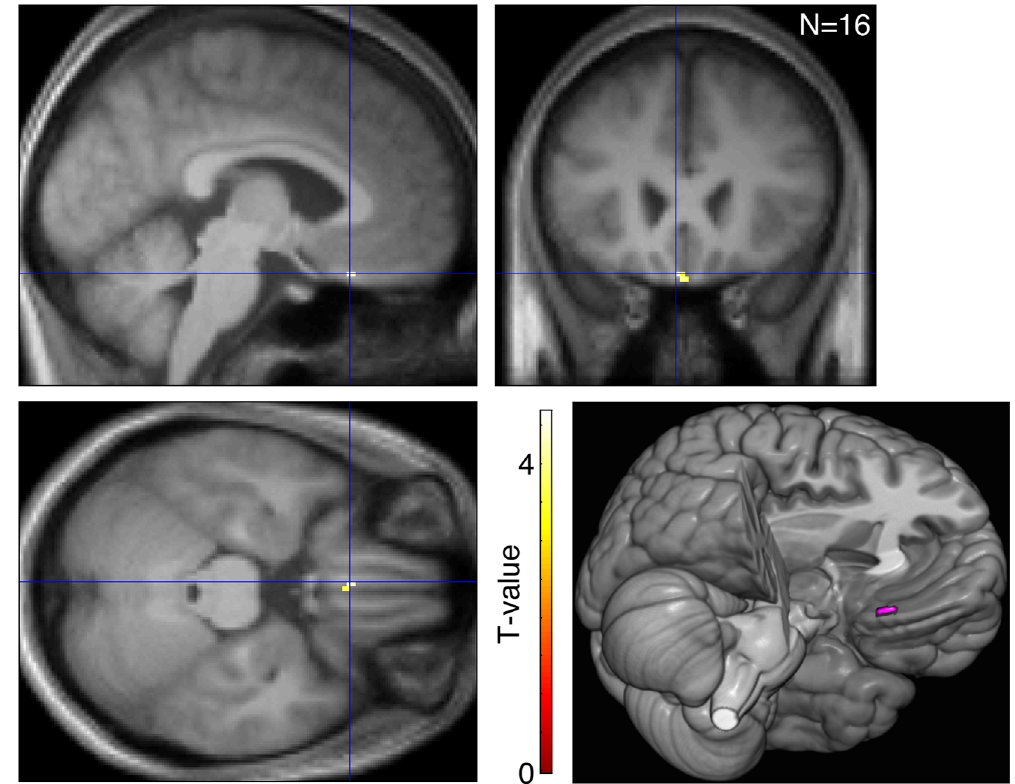
Figure 2. The mOFC was the only region that was significantly more activated during the attractiveness task block than during the reflection task block. The crosshairs indicate the peak voxel of the cluster (MNI: − 4, 24, − 24). An effect size metric Hedges’ g av 139 of this contrast in the beta values in this voxel was 1.138. The lower- right panel image was rendered using MRIcroGL software (https ://www.mccau sland cente r.sc.edu/mricr ogl/